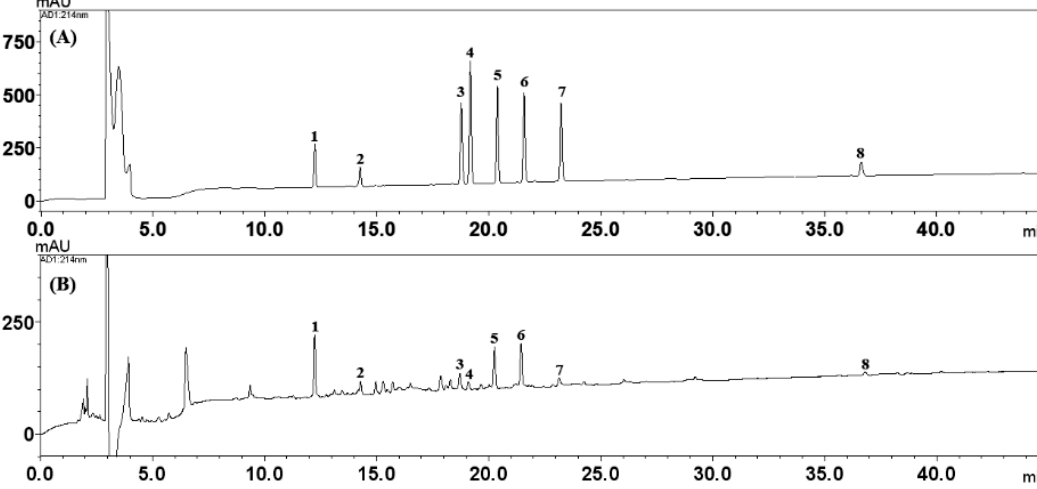
Figure 1. Representative HPLC chromatograms of ( A ) standard solution of all analytes and ( B ) HPYJT sample at 214 nm. ( 1 ) MULA, ( 2 ) AMY, ( 3 ) LIQA, ( 4 ) LIQ, ( 5 ) NAR, ( 6 ) HES, ( 7 ) RA, and ( 8 )